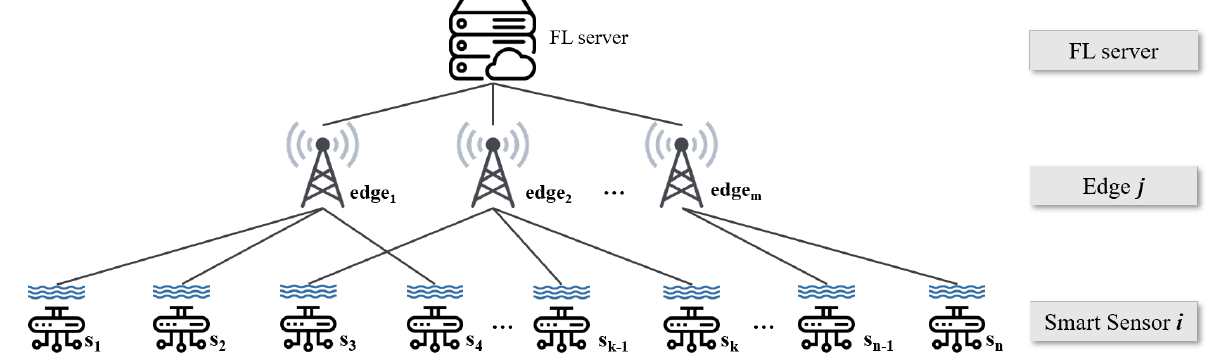
Figure 1. Overall network architecture.